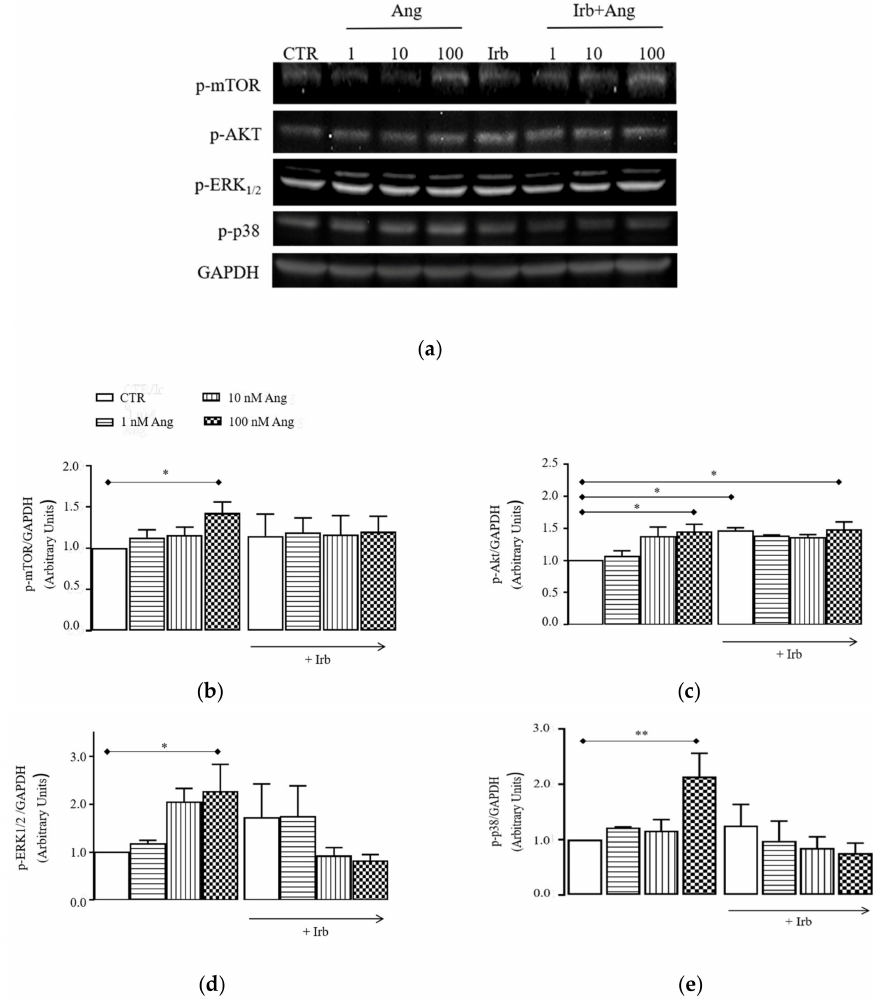
Figure 3. Signaling cascade stimulated by acute Ang in hSCs: ( a ) representative immunoblotting of p-mTOR, p-AKT, p-ERK1 / 2, p-P38, and GADPH detected in protein extracts of cultured hSCs stimulated or not (CTR) with 1–100 nM angiotensin II (Ang) for 15 min with / without 1 µ M irbesartan (Irb); densitometric analysis of p-mTOR ( b ), p-AKT ( c ), p-ERK1 / 2 ( d ), and p-P38 ( e ) levels, reported as ratios between the levels of the target protein and GAPDH. Results are presented as mean ± SEM of the three gels. * p < 0.05 vs. CTR, ** p < 0.01 vs.